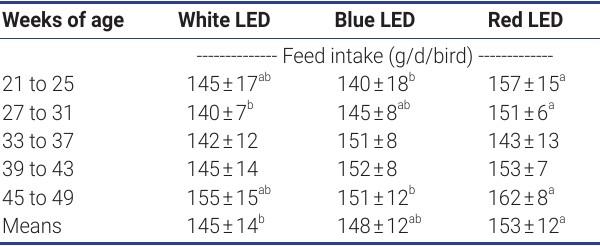
Table 4. The feed intake of Brown Tsaiya ducks in different treat- ment groups